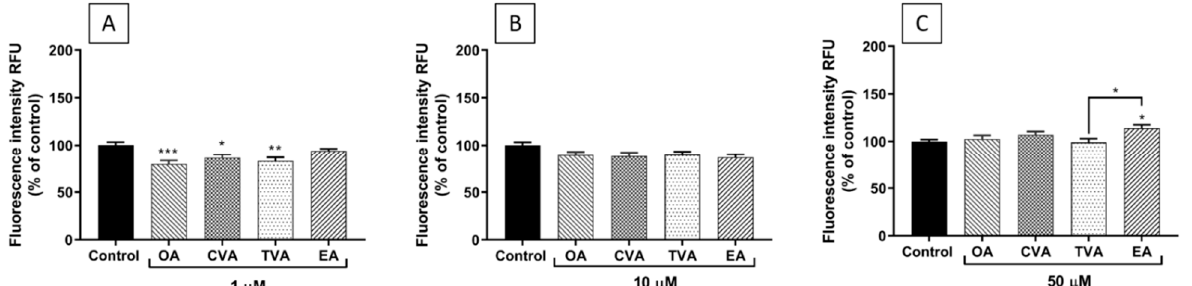
6 of 16 Figure 5. Expression of NF κβ 1 ( A ), TLR-4 ( B ), PTGS2 ( C ), and IL-6 ( D ) genes in EA.hy926 cells preincubated for 48 h with 1, 10, and 50 μ M of FA in DMEM containing 0.1% of ethanol (Control) followed by incubation with TNF- α (1 ng/mL) for 6 h. Cq values were normalised by the geometric mean of reference targets RPL13A and CYC1 genes. Bars are mean ± SEM of 9 samples performed in 3 experiments. Data were analysed using one-way ANOVA with Tukey’s as post hoc test. * p < 0.05, ** p < 0.01 between groups indicated by joined lines or vs. Control when there is no joined line. OA = oleic acid, CVA = cis vaccenic acid, TVA = trans vaccenic acid, EA = elaidic acid. 2.5. Effects of FAs on THP-1 Adhesion to EA.hy926 Cells